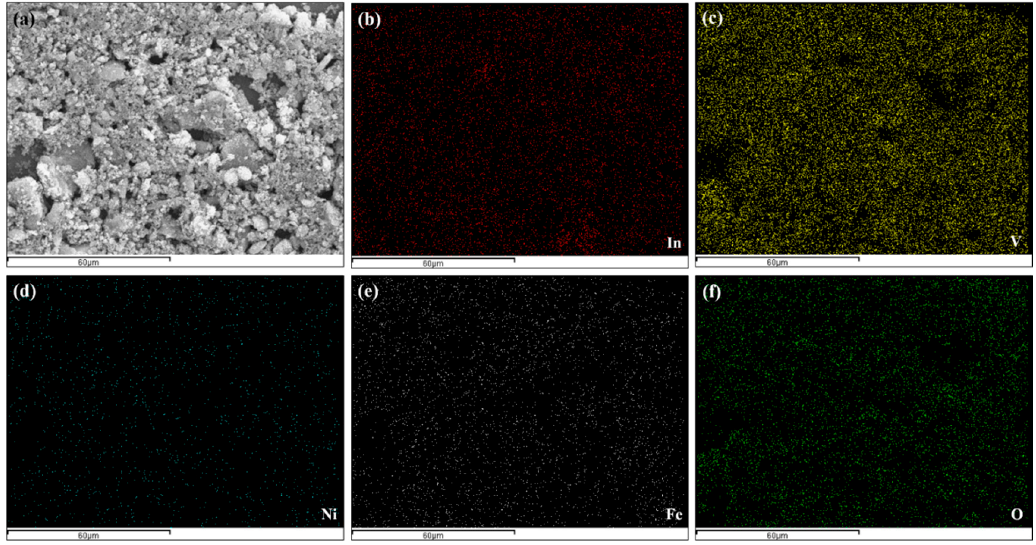
Figure 4. EDS elemental color mapping of the IVNF-5.0 nanocomposite. ( a ) Mapping region, ( b ) In, ( c ) V, ( d ) Ni, ( e ) Fe, and ( f ) O.